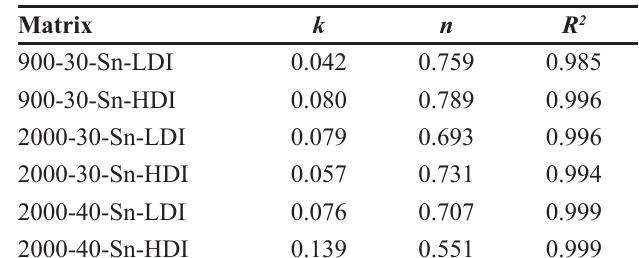
TABLE II - Values for k and n (± 95% confidence intervals) obtained by log plot of hydrocortisone release curves from tablets of different compositions at pH 7.4. R 2 values are